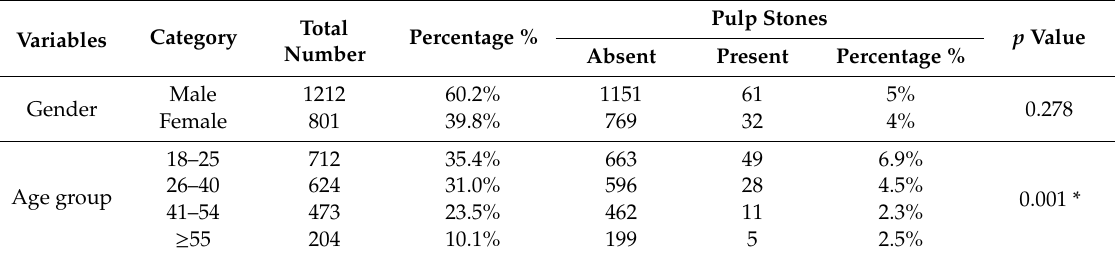
Table 2. Descriptive analysis of study variables and the relation to pulp stones ( n =